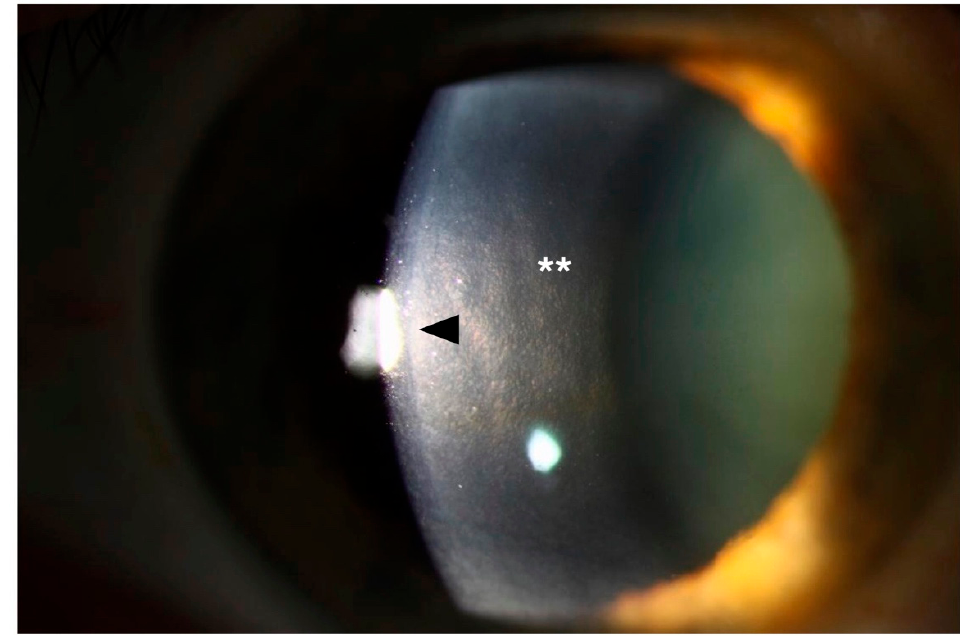
Figure 3. Extracellular fibrosis (arrowhead) and dense guttae (**) in the posterior cornea secondary to Fuchs endothelial corneal dystrophy.